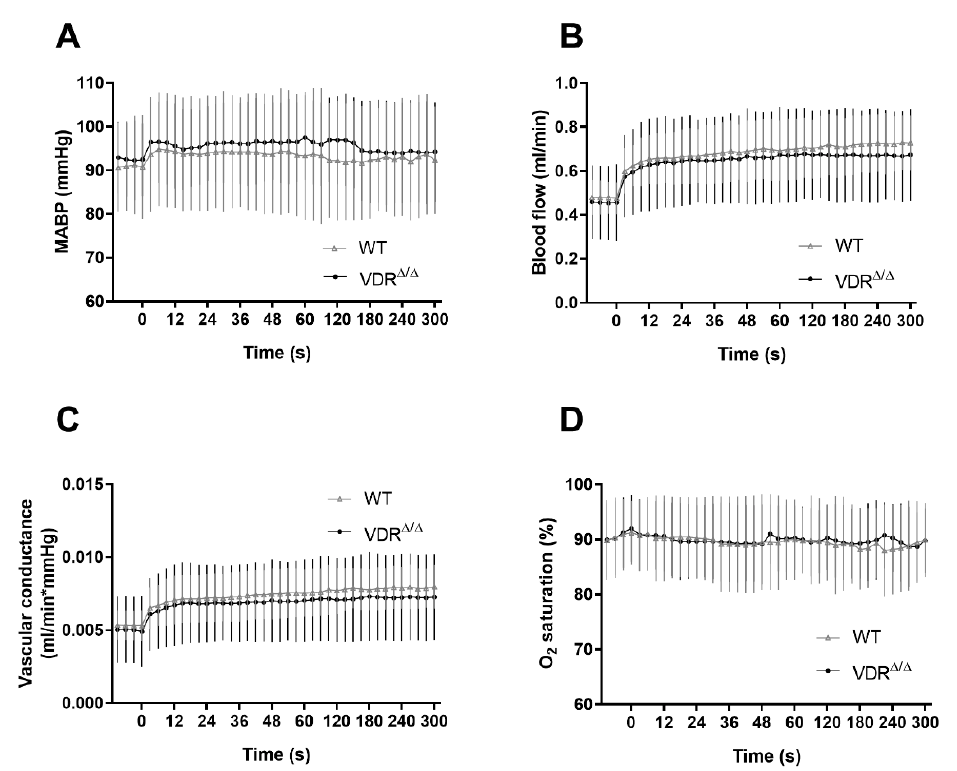
Figure 5. Changes of the systemic blood pressure, contralateral carotid arterial blood flow, and vascular conductance as well as arterial O 2 saturation after unilateral carotid artery occlusion (CAO). ( A ) CAO caused a minor increase in the mean arterial blood pressure (MABP) and ( B ) a more pronounced increase in the contralateral carotid artery blood flow, resulting ( C ) in increased vascular conductance of the contralateral carotid artery. ( D ) The O 2 saturation was not affected by CAO. Zero time indicates the moment of the left carotid artery occlusion. Neither parameters were different between the groups ( n = 6 in both groups, two-way repeated measures ANOVA followed by Bonferroni post hoc test). Data are presented as mean ± SD.